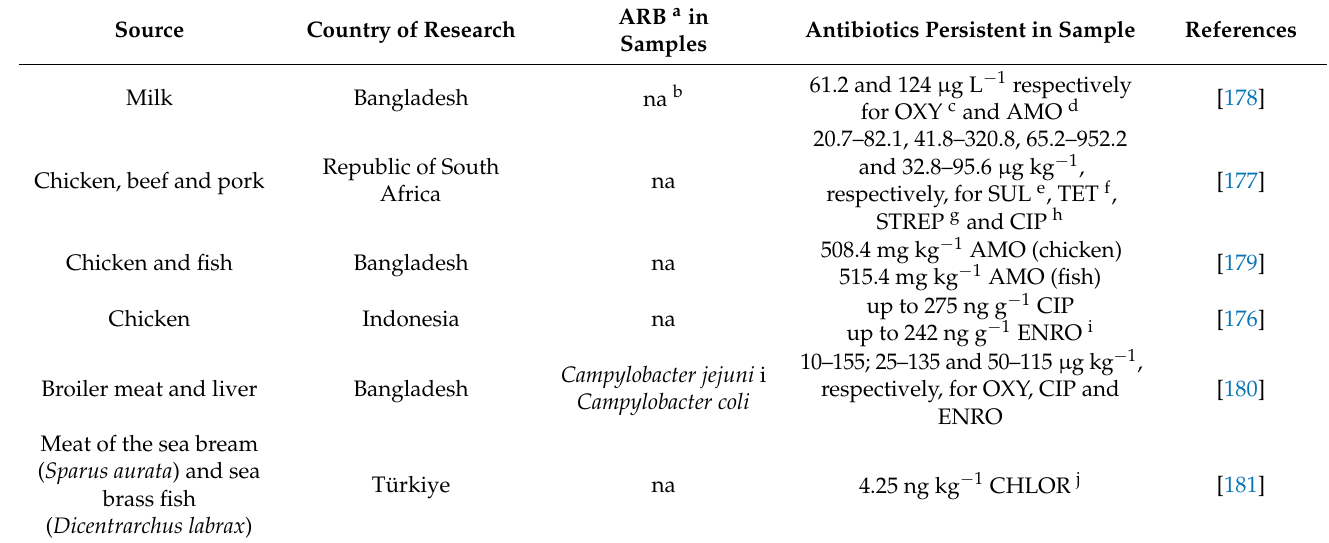
Table 10. The presence and concentration of various antibiotics in selected food samples of animal